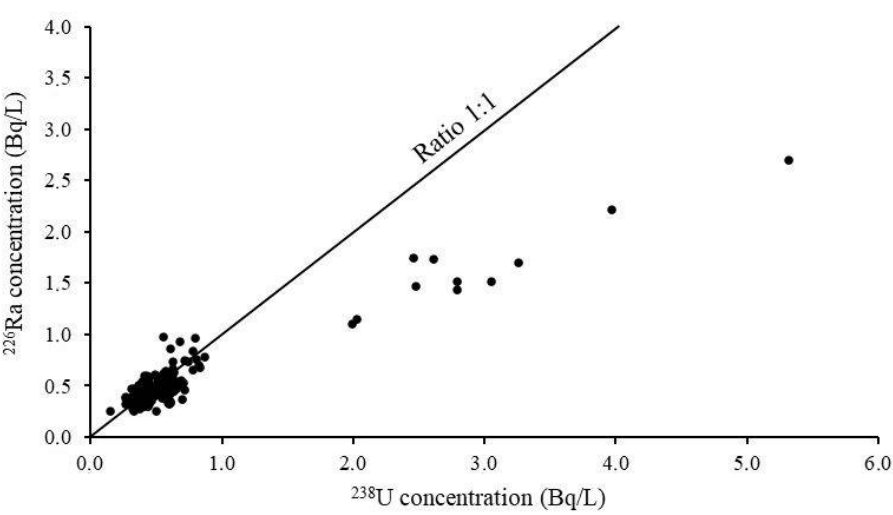
Figure 2. Relationship between 238 U and 226 Ra